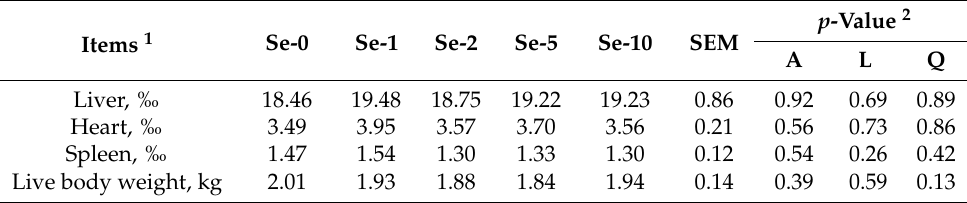
Table 8. Effects of dietary organic selenium on the organ indexes of laying hens.